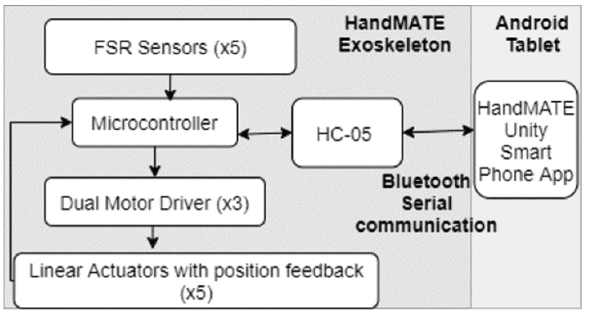
Figure 15. HandMATE’s control algorithm; The device uses the Force Sensitive Resistors (FSRs) at each joint to decipher the input before assisting in completing the exercise [45].